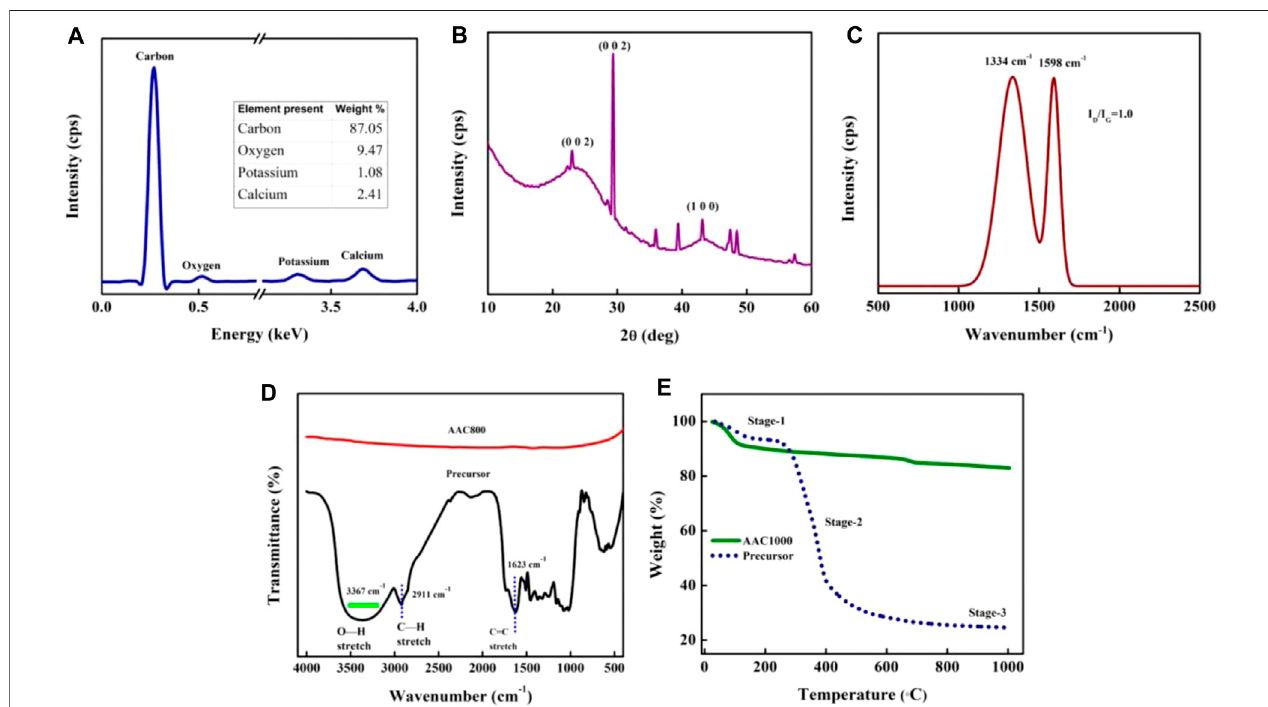
FIGURE3| EDSspectrum (A) ,XRDplot (B) ,andRamanspectrum (C) ofAAC800,FTIRspectrumoftheprecursorandAAC800 (D) ,andTGAplotoftheprecursor and AAC1000 (E) .